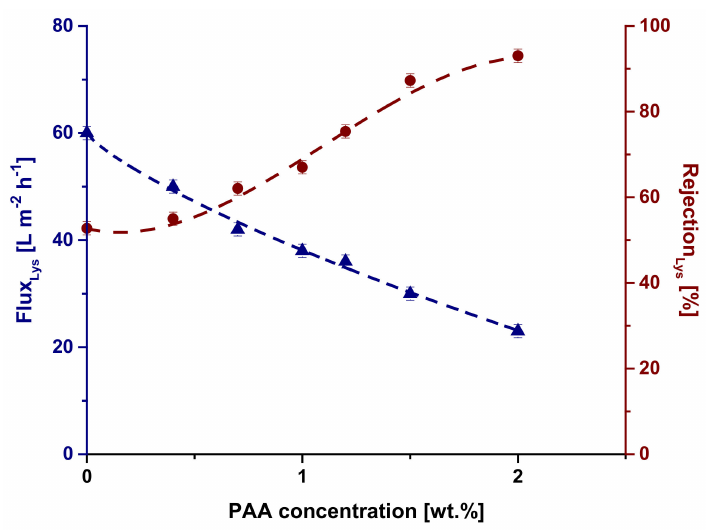
Figure 10. The dependence of the lysozyme solution flux (Flux Lys ) and lysozyme rejection coefficient (Rejection Lys ) on PAA